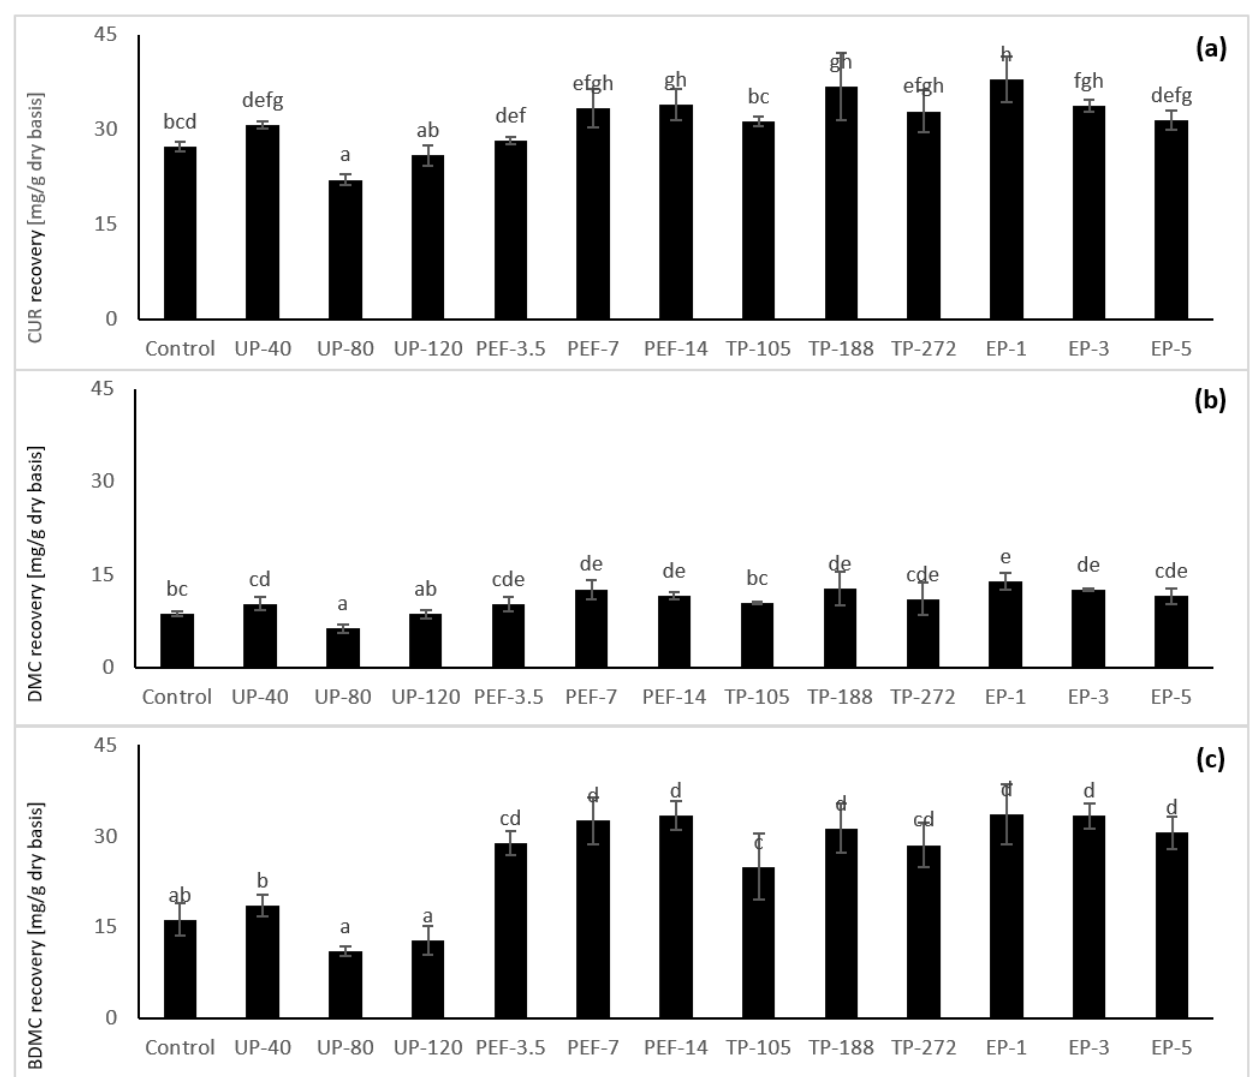
Figure 3. Effect of pretreatment techniques on Curcumin (CUR) ( a ), Demethoxycurcumin (DMC) ( b ) and Bis-demethoxycurcumin (BDMC) ( c ) recovery of fresh turmeric. In a panel, values with the same lowercase letter are not considering as significantly different ( p < 0.05).